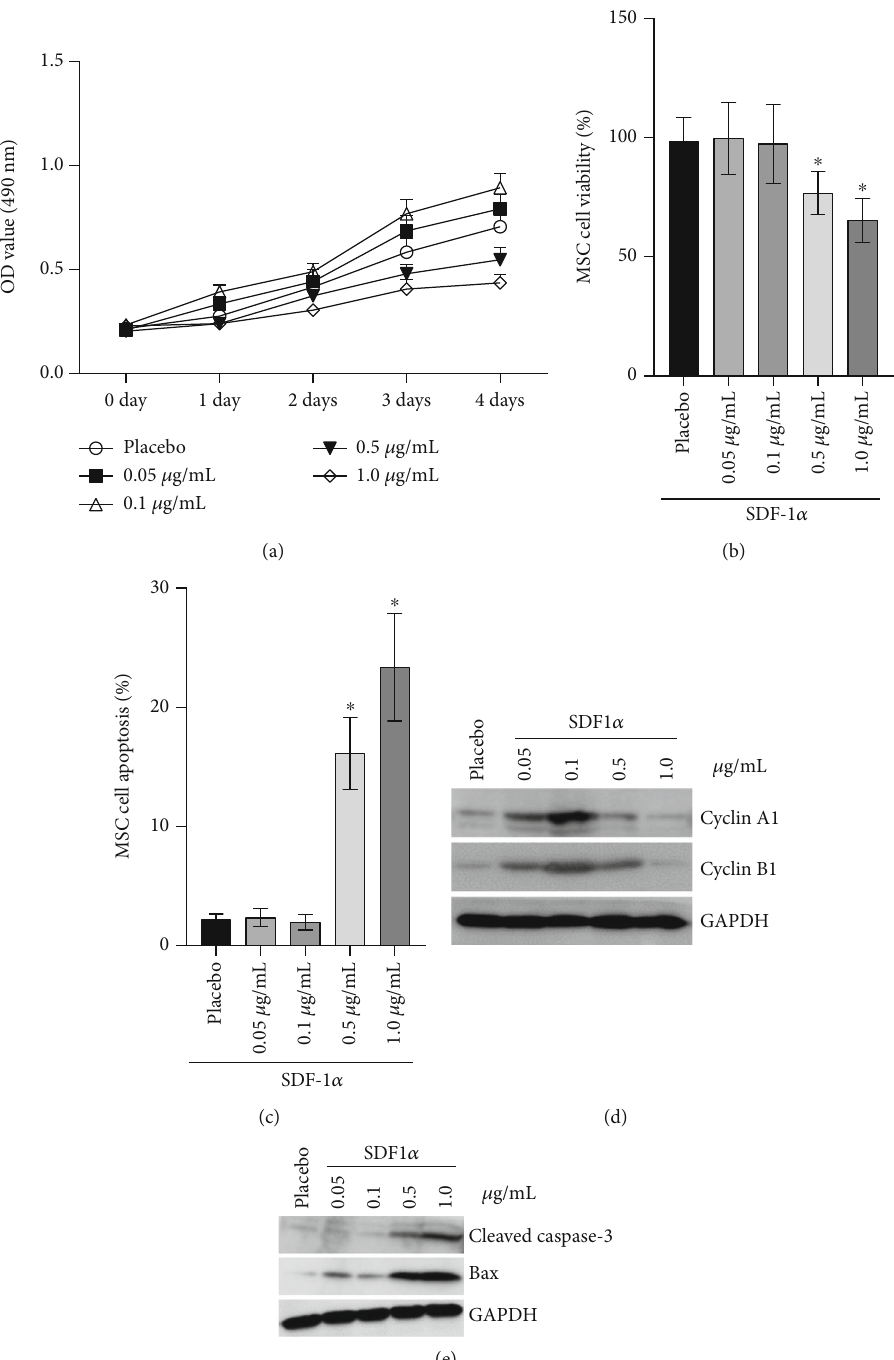
Figure 2: SDF-1 α a ff ects the survival of MSC by regulating the level of cyclin A1, cyclin B1, caspase-3, and Bax. (a) The e ff ects of di ff erent doses of SDF-1 α on the proliferation of MSCs. (b, c) The e ff ects of di ff erent doses of SDF-1 α on the cell viability and cell apoptosis of MSCs. The viability rate and apoptotic rate had no di ff erence at the concentrations of 0.05 μ g/mL and 0.1 μ g/mL SDF-1 α ; however, 0.5 μ g/mL and 1.0 μ g/mL SDF-1 α could decrease the viability rate and increase the apoptotic rate (2.19 ± 0.48% vs. when compared to the control). (d, e) The e ff ects of di ff erent doses of SDF-1 α on the expression of cyclin A1, cyclin B1, caspase-3, and Bax in MSCs. ∗ P < 0 : 05